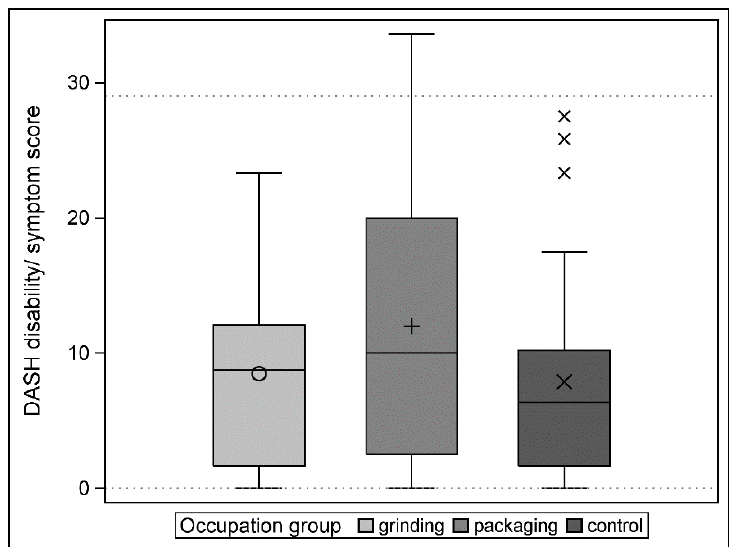
Table 4. Disabilities of the Arm, Shoulder and Hand (DASH) scores.